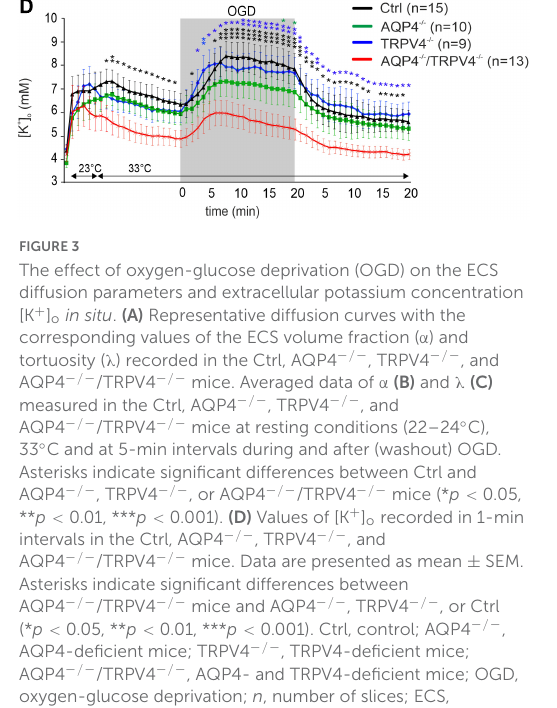
Ctrl and AQP4 − / − /TRPV4 − / − mice (4.5 ± 0.4 mM